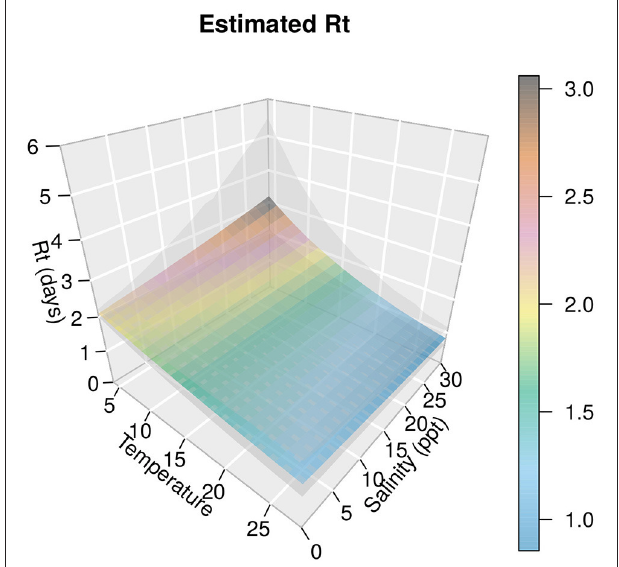
FIGURE 2 | Surface plot of the model with credible intervals (gray planes above and below the median of model estimates in color). Color code indicates the observed (data points) and estimated (plane) value of decay rates a . The vertical lines show the distance between data points and the plane (without random effects) estimated by the model.